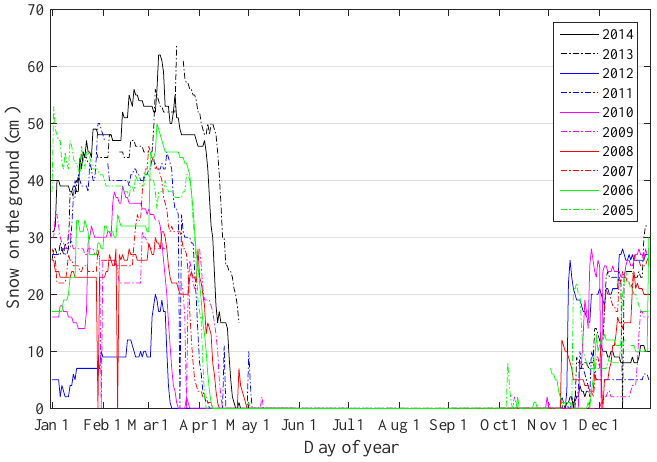
Figure 3. Snow depth (in cm) measured at the Marquette